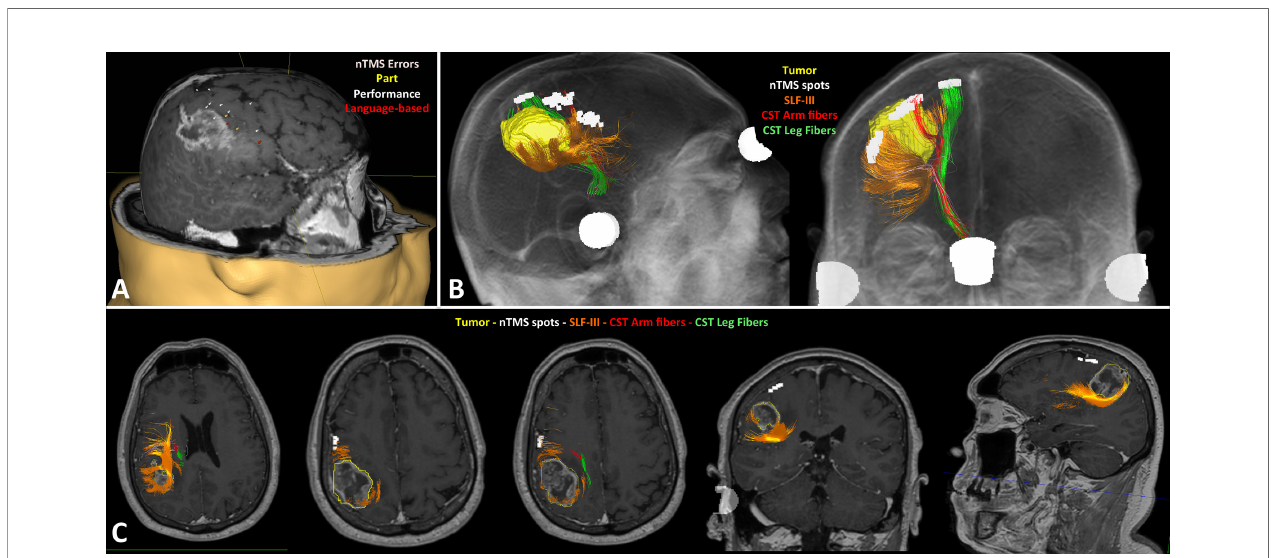
FIGURE 6 | Case example of the preoperative planning in a right fronto-parietal glioblastoma. The nTMS mapping of VSAs identi fi ed several eloquent cortical sites of the VS network (A) ; the DTI tractography showed the tumor (yellow) was very close to the SLF-III (orange), but also to the corticospinal tract (CST; arm fi bers in red, leg fi bers in green) (B) ; the fusion MRI scan con fi rmed the SLF-III was in fi ltrated by the posterior part of the tumors, as visible in the different axial, coronal and sagittal slices; conversely, the nTMS cortical spots are far away from the tumor (C) .